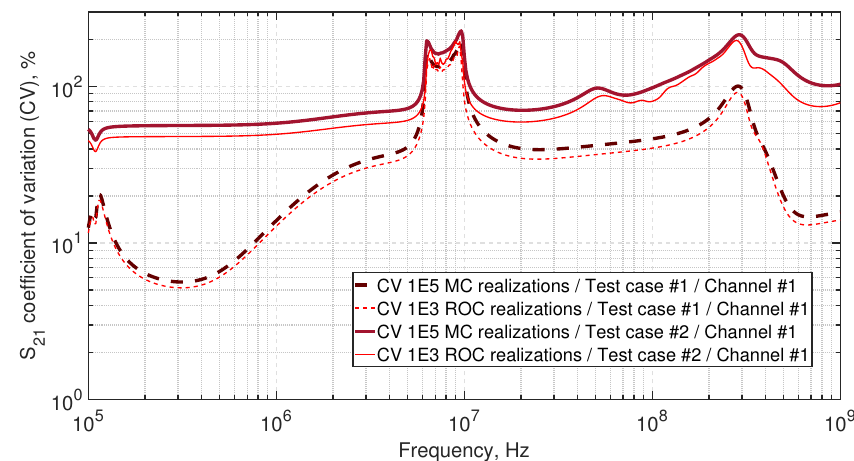
Figure 19. S 21 CVs from Test cases #1 and #2 (Channel #1 configuration).